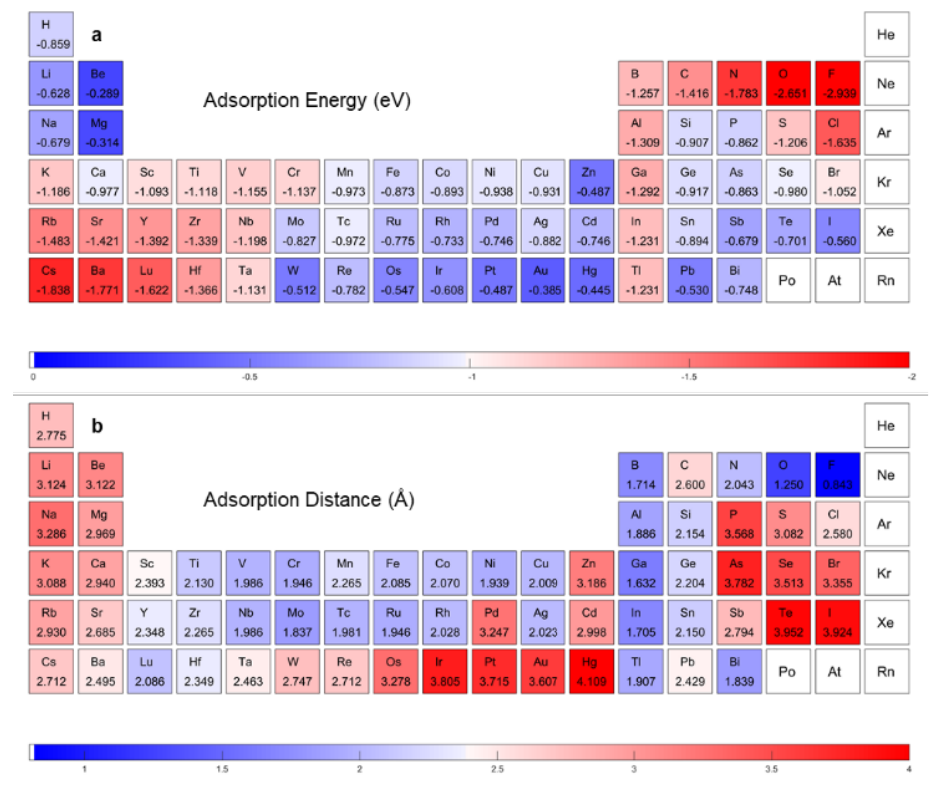
Figure 6. Adsorption properties prediction with our network. ML accelerated DFT-calculated ( a ) adsorption energy and ( b ) adsorption distance. Table 1. DFT-calculated interfacial distance ( d inter ) and cohesive energy ( E coh ) of graphene/Mg + M